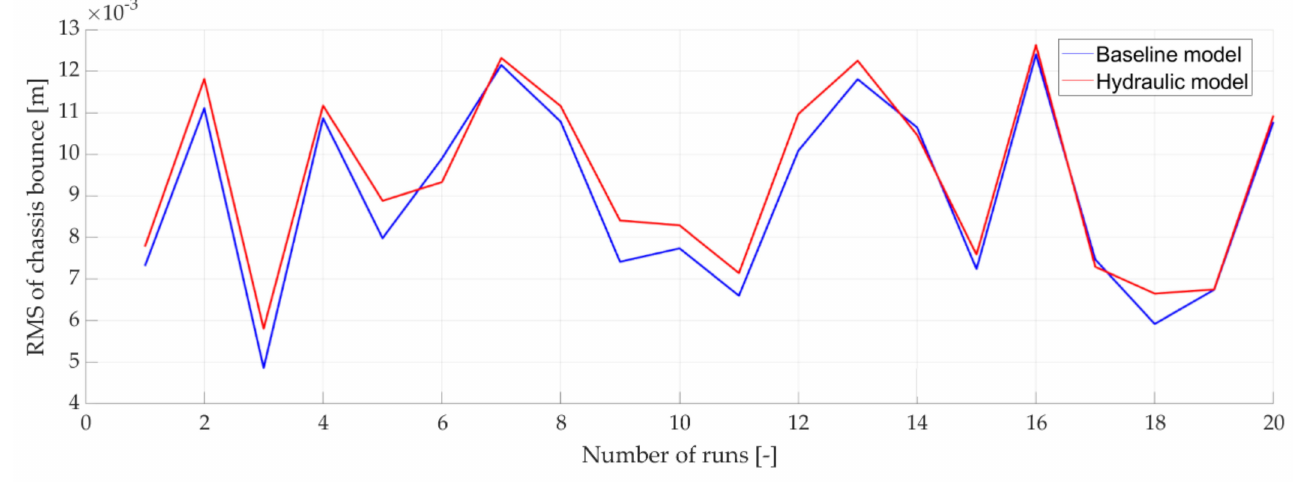
Figure 27. Chassis bounce root mean square for a realistic road profile and external accelerations.